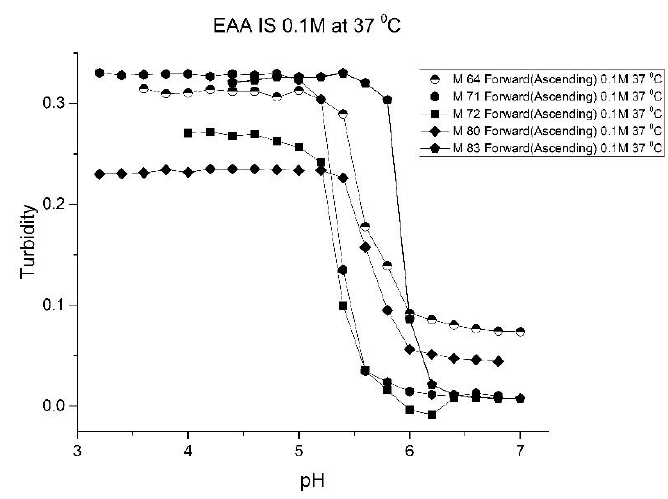
Figure 5. Ascending pH profiles at 23 °C for a variety of N -isopropylacrylamide copolymers of ethacrylic acid: M-64, M-71, M-72, M-80, and M-83.